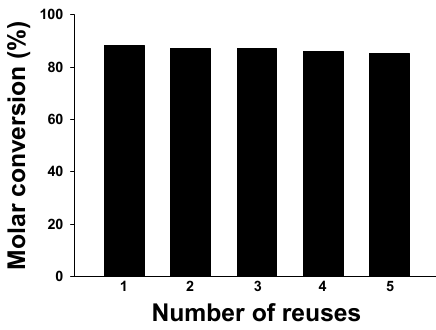
Reusability of the immobilized lipase on the synthesis of 2-ethylhexyl salicylate. Reusability was evaluated under the experimental conditions including a reaction time of 23.1 h, a reaction temperature of 66.5 °C, and an enzyme amount of 881 PLU.